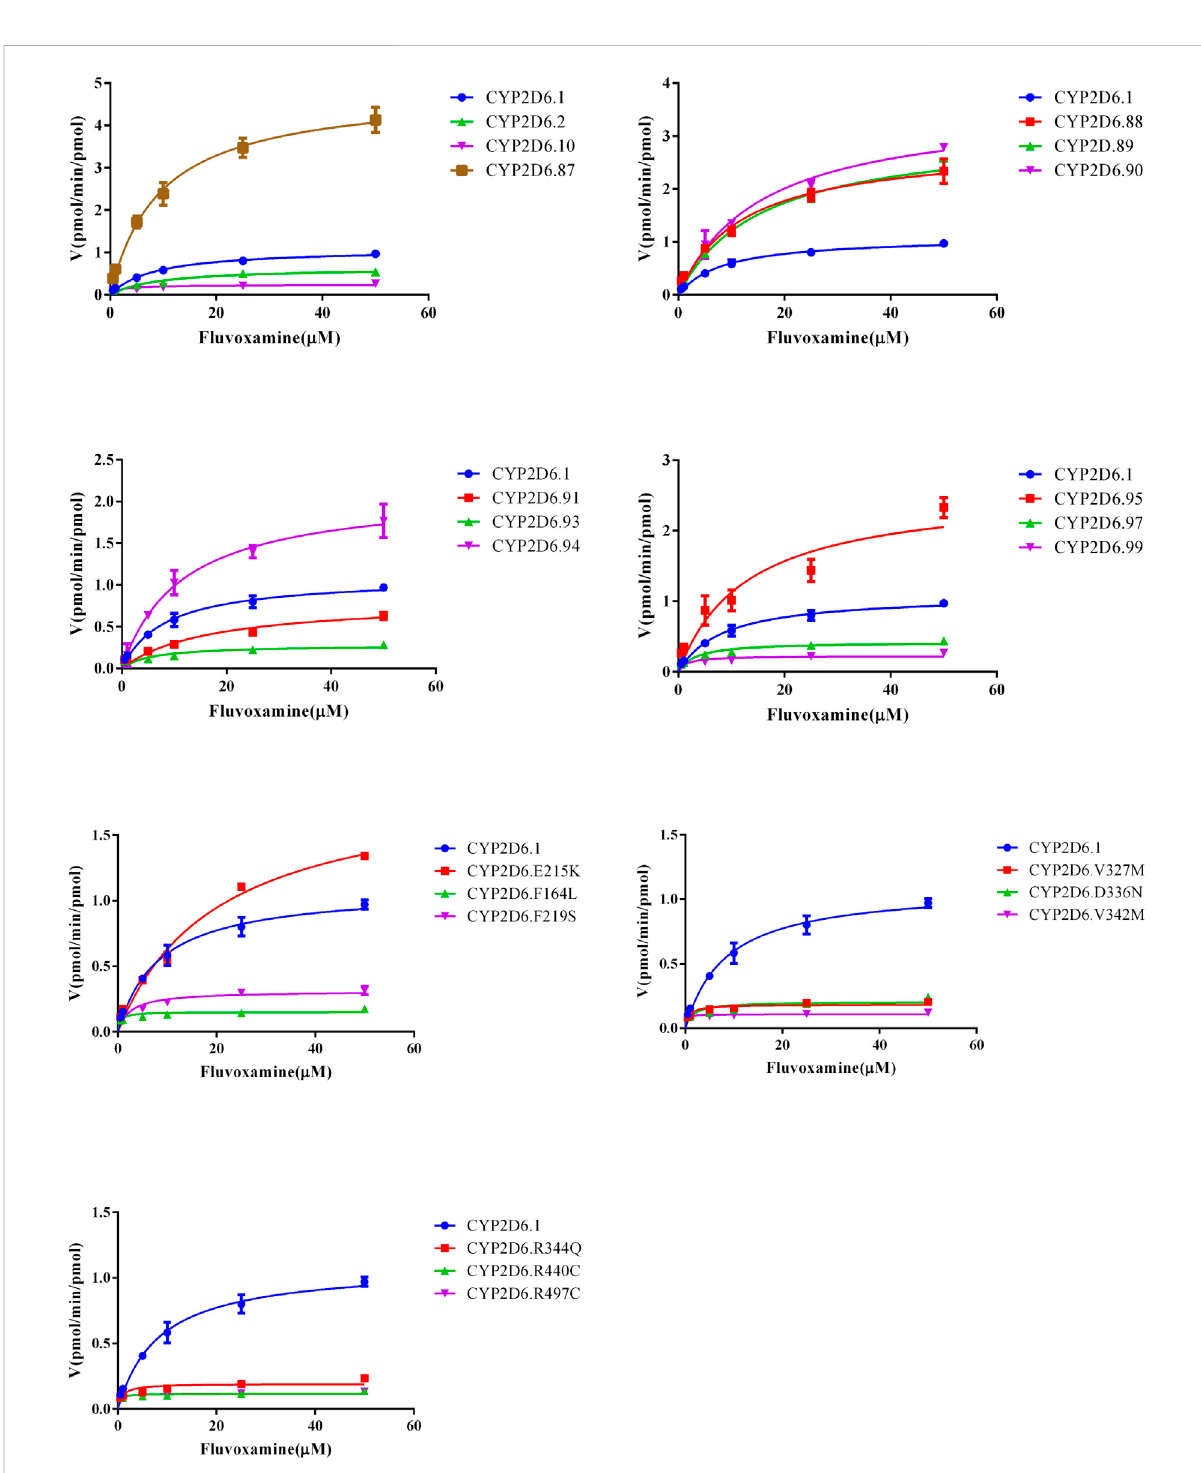
FIGURE 2 Michaelis – Menten curves of CYP2D6 in disposition of fl uvoxamine. The reaction was performed as indicated in the section of method, n = 3.